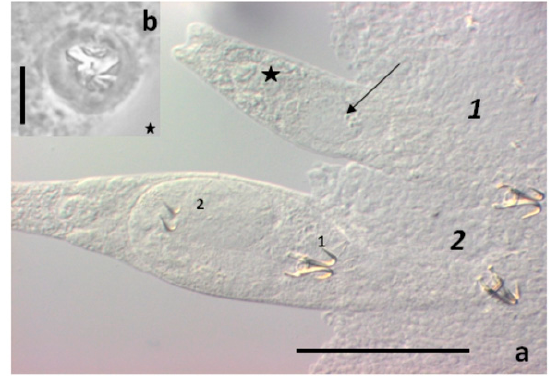
Figure 1. Light micrographs of Gyrodactylus gasterostei . ( a ) An individual parasite (1) showing an empty uterus (arrow) and pharynx (star), and another parasite (2) showing the presence of a daughter ( 1 ), (and granddaughter ( 2 ) in utero. Scale bar = 0.5 mm; ( b ) Male copulatory organ. Scale bar = 10 µm.